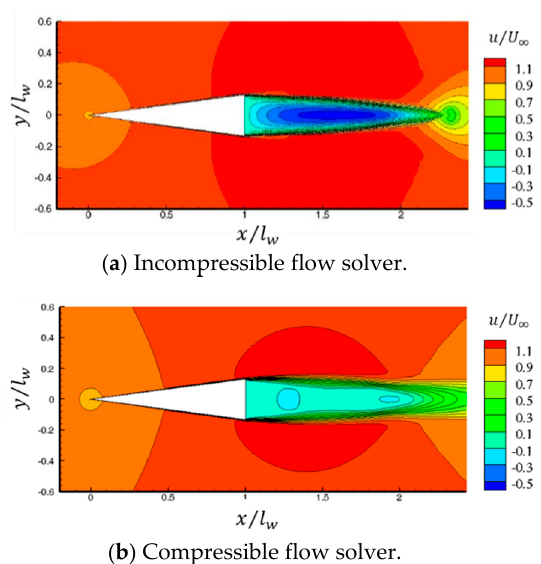
Figure 8. Non-dimensionalized x-velocity contours around wedge at σ = 0.35.